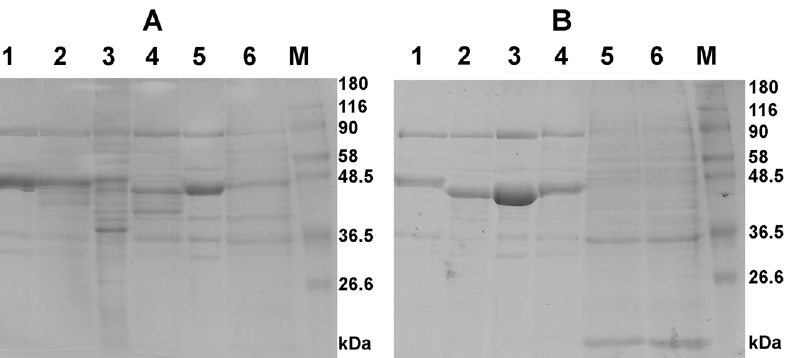
Figure 2. Salmonella secreted proteins. Panel A, strains included in the initial part of this study. 1, S . Enteritidis 147. 2, S . Enteritidis 147 rfaL mutant. 3, S . Typhimurium LT2. 4, S . Typhimurium LT2 rfaL mutant. 5, S . Infantis 1516. 6, S . Infantis 1516 rfaL (I) mutant. Lane M, molecular weight standard. This analysis was repeated 3 times for each strain or mutant with similar results in each of the replicates. Panel B, strains included in the second part of this study. 1, S . Enteritidis G1481. 2, S . Typhimurium 2002. 3, S . Typhimurium 2454. 4, S . Infantis 514. 5, S . Infantis 1516 rfaL (II) mutant. 6, S . Infantis 1516 rfaL (III) mutant. Lane M, molecular weight standard. This analysis was repeated 3 times for each strain or mutant with similar results in each of the